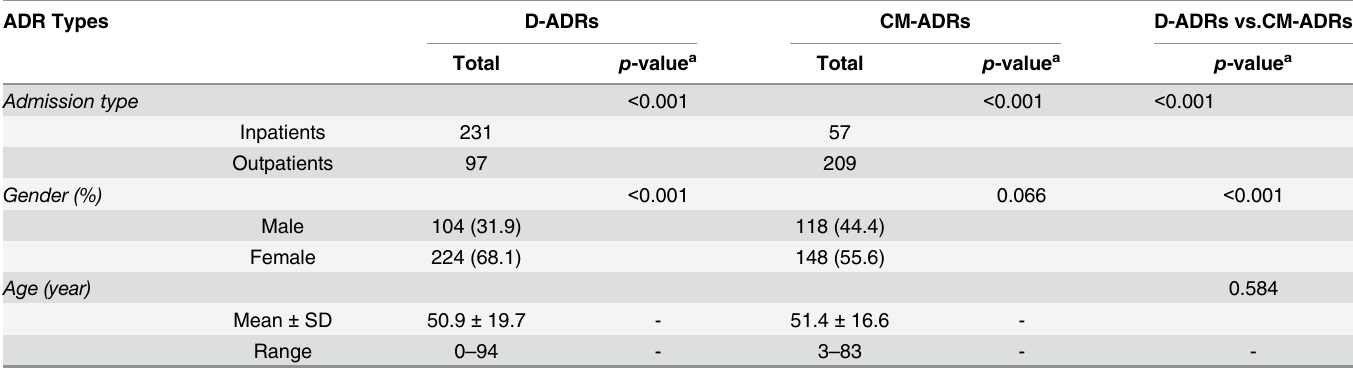
Table 1. Patient characteristics.